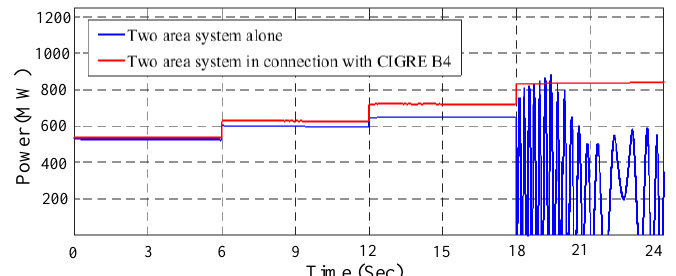
Figure 9. Power profile for (i) standalone Kunder’s AC network (blue lines) and (ii) interconnected AC/DC systems of Figure 1 (red lines).